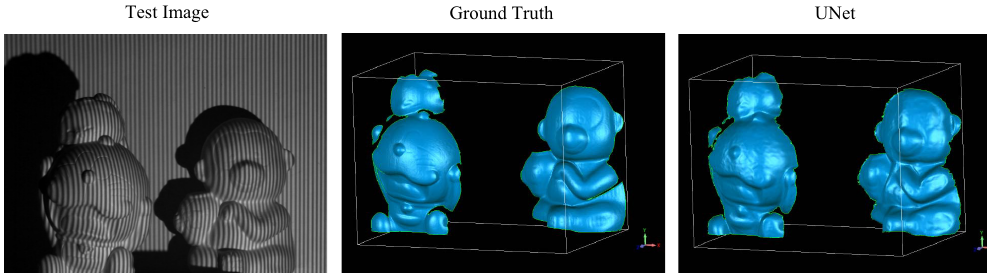
Figure 5. Height distributions: ( a ) along a line highlighted in the first test image in Figure 4, ( b ) along a line highlighted in the second test image in Figure 4.